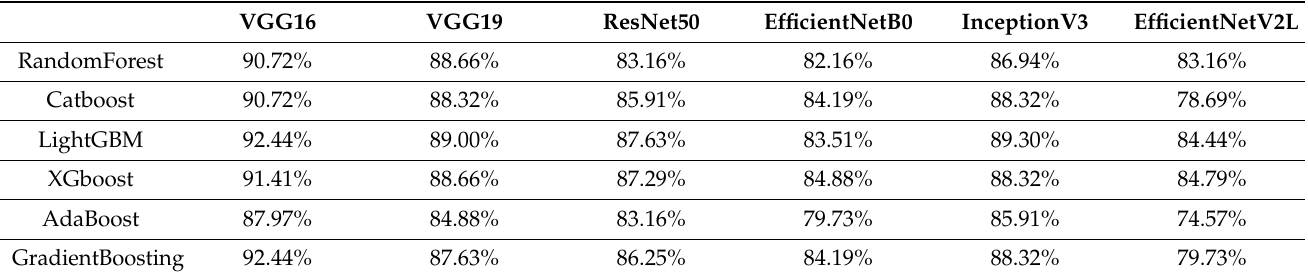
Table A7. Accuracy of each model combination for all gray-colored